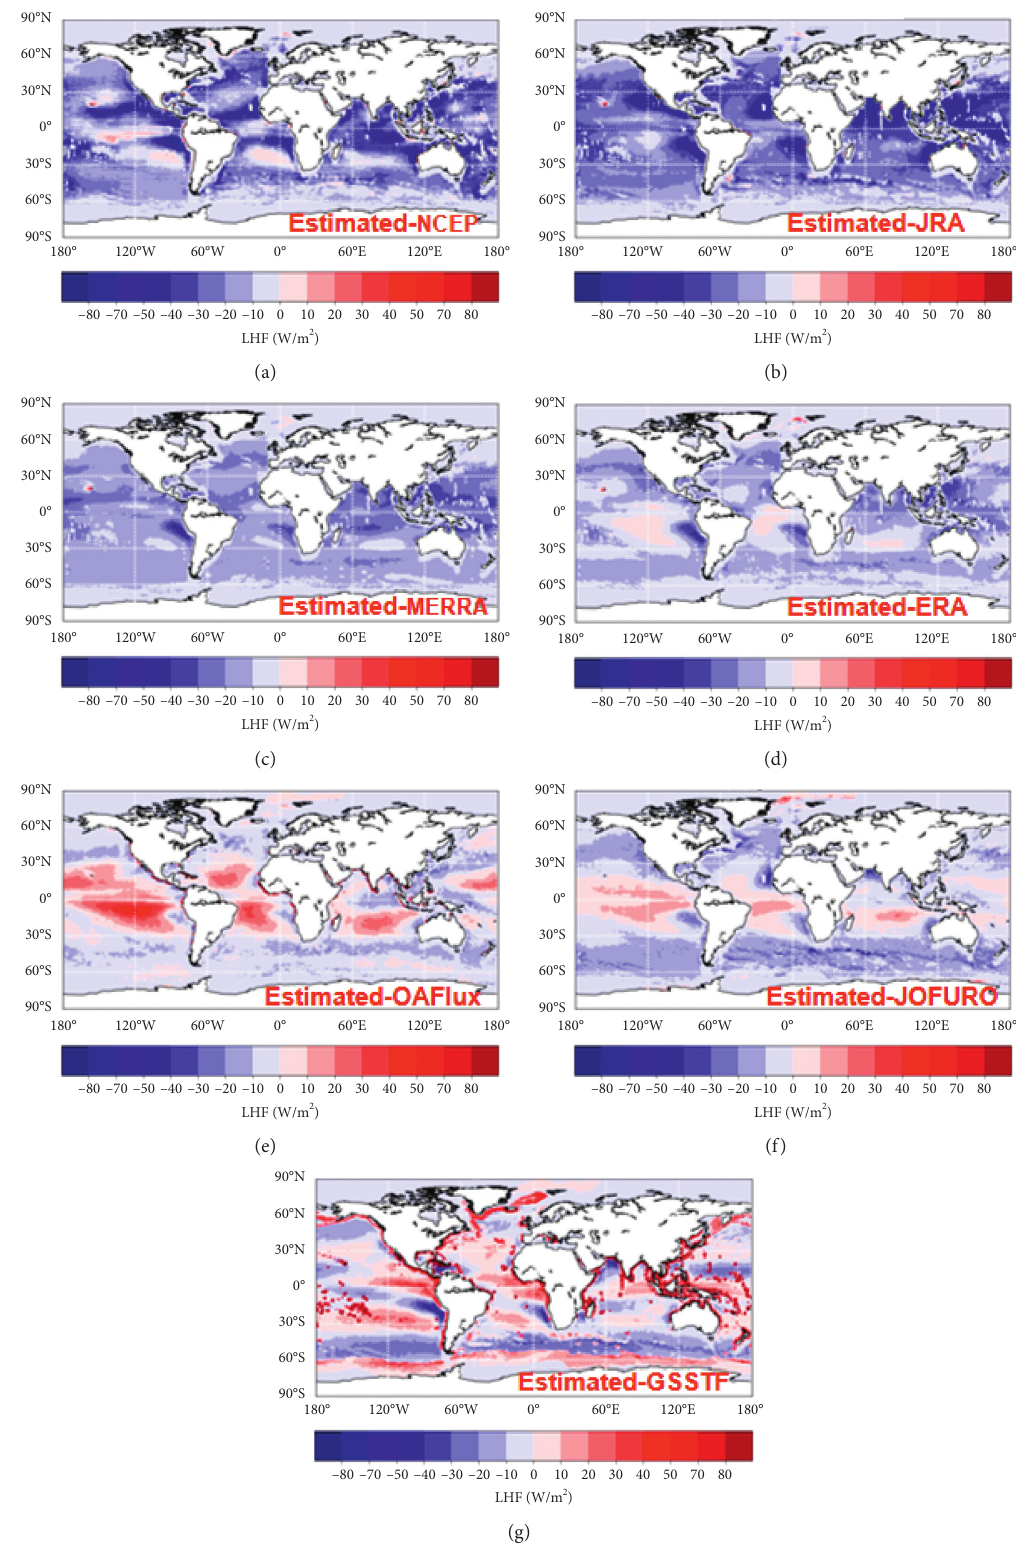
Figure 8: Spatial patterns of difference between our estimated LHF and other LHF products over the period from 2003 to 2007: (a) NCEP-2; (b) JRA-25; (c) MERRA-2; (d) ERA-I; (e) OAFlux; (f) J-OFURO; (g)